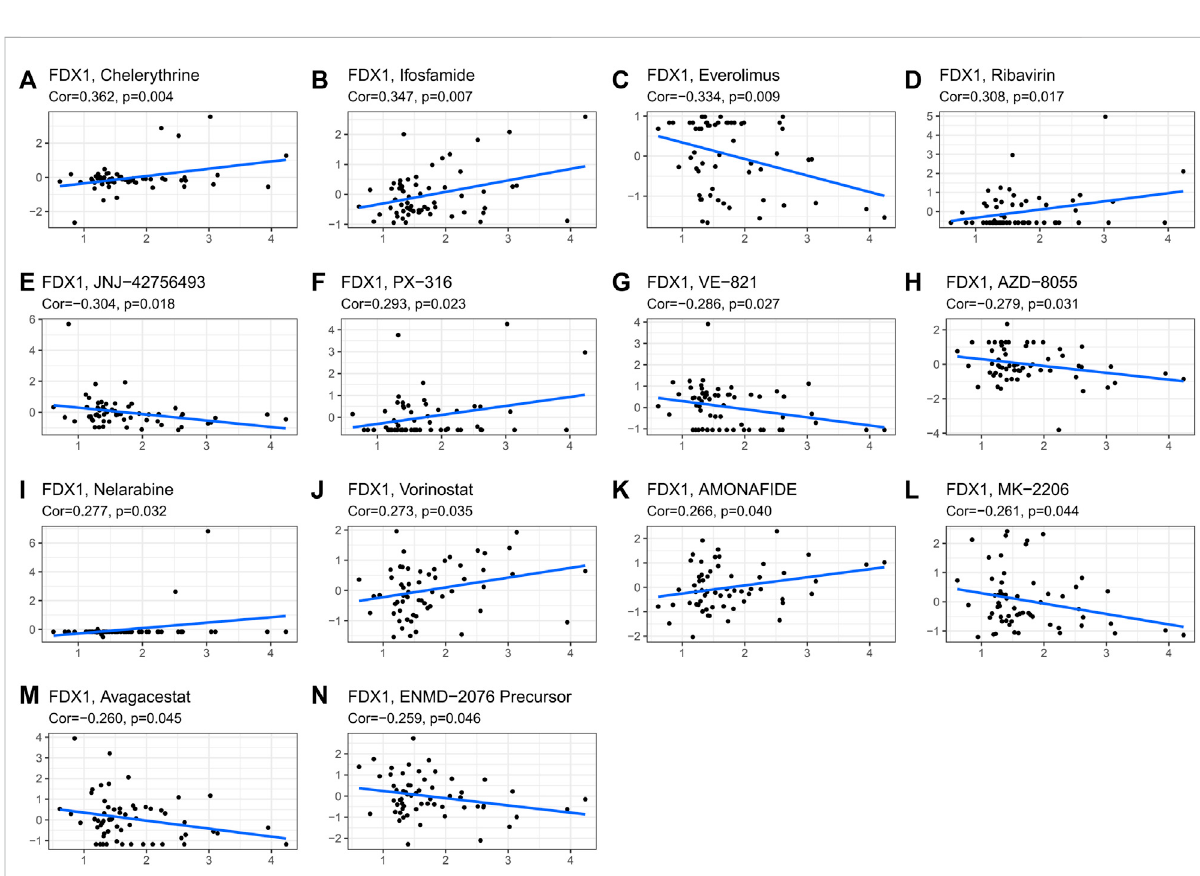
FIGURE 10 Correlation graph withdrug IC50.Thecorrelationgraphofgeneand drugIC50 andtheslopeofthestraight linearethecorrelation coef fi cients between gene and drug. [ (A) : chelerythrine, (B) : ifosfamide, (C) : everolimus, (D) : ribavirin, (E) : JNJ-42756493, (F) : PX-316, (G) : VE-821, (H) : AZD- 8055, (I) : nelarabine, (J) : vorinostat, (K) : AMONAFIDE, (L) : MK-2206, (M) : avagacestat, and (N) : ENMD-2076